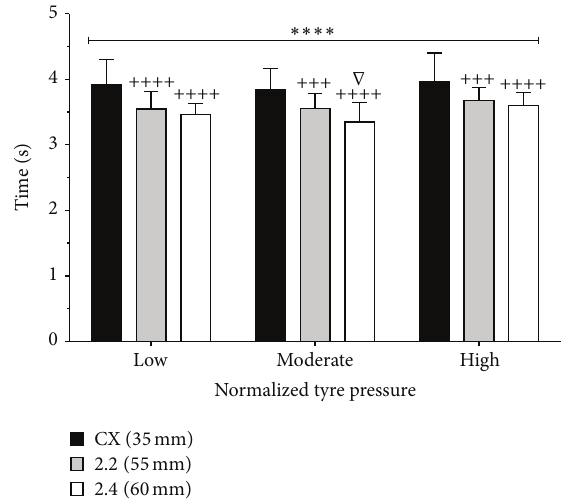
Figure 4: Mean ± SD for performance time (s) over the trial protocol (Figure 1). ∗∗∗∗ (𝑃 < 0.0001) main effect of tyre; post hoc differences when comparing tyres for within-tyre inflation pressures when compared to CX: ++++ (𝑃 < 0.0001) , +++ (𝑃 < 0.001) , and 2.2; ∇ (𝑃 < 0.05)